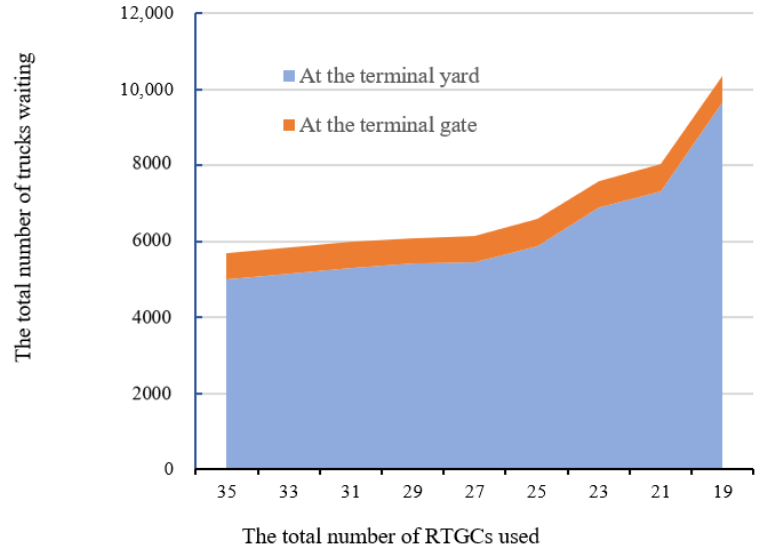
Figure 14. The effect of the number of RTGCs deployed on the queuing